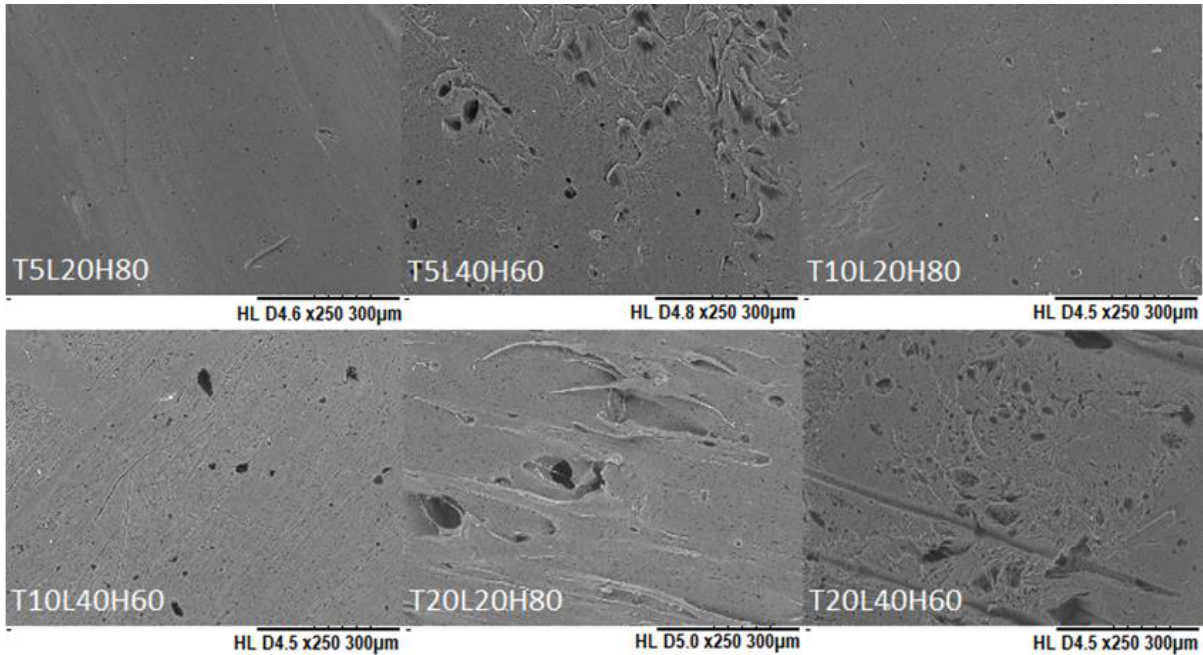
Figure 8. SEM images of PCL implants after in vitro release over 180 days.